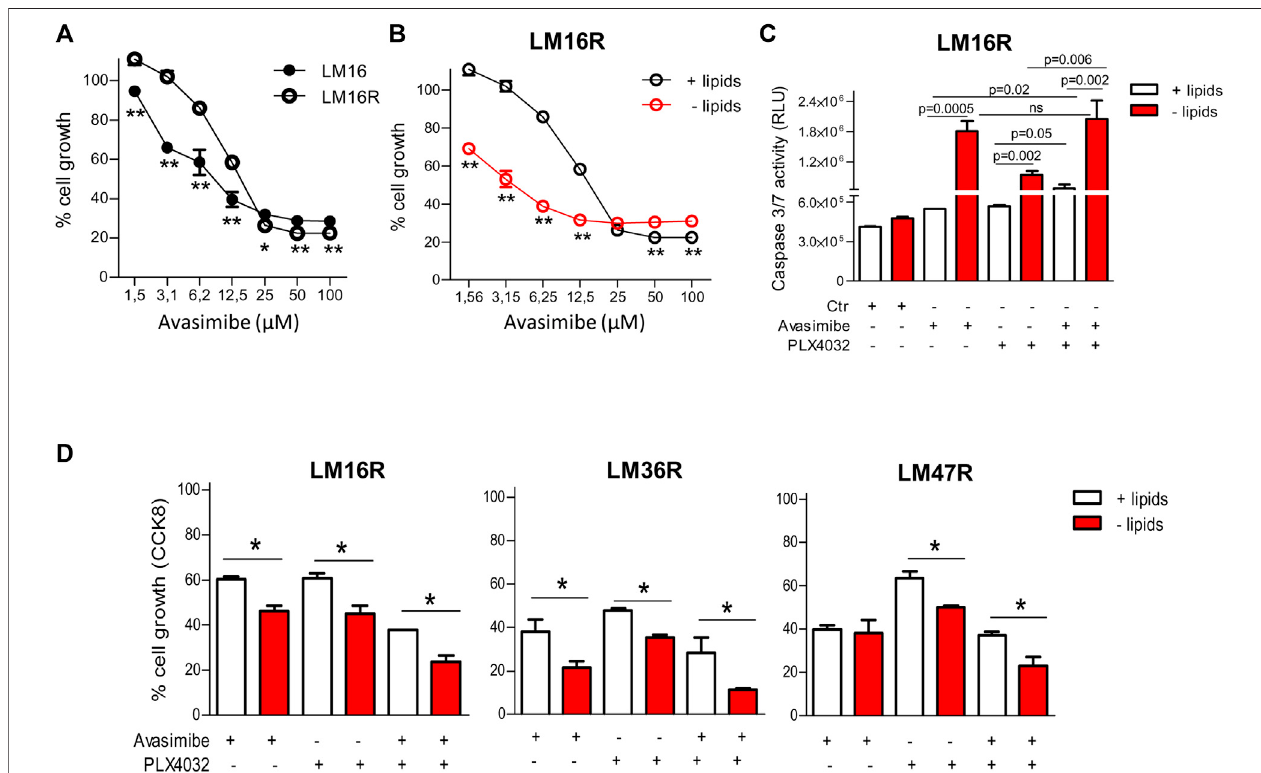
FIGURE 6 | Antiproliferative effects of avasimibe and of the combined treatment with PLX4032 in melanoma cell lines. (A) . Sensitivity of LM16/LM16R cells to avasimibeinstandardcultureconditions.IC 50 valuesofavasimibeforLM16RandLM16parentalcellswere17.1and11.1 µMinstandardculturemedium. (B) .Sensitivity ofLM16R cellstoavasimibe instandardculture conditionand uponlipid starvation. IC 50 valuesofavasimibe were17.1 µM instandardconditionand 4.2 µM inlipid-free medium. In (A) and (B) ** p < 0.01 by Two-way ANOVA followed by Bonferroni correction. (C) . Apoptosis induction after 48 h treatment with avasimibe (12.5 µM) and PLX4032 (3 µM) and with the combination in standard and lipid-free medium as detected by caspase 3/7 activity. p values by unpaired Student ’ s t test. ns: not signi fi cant. Ctr: untreated control. (D) . Sensitivity of LM16R, LM47R and LM36R cells to avasimibe (25 µM), PLX4032 (3 µM) alone or in combination as determined by CCK8assay.Dataareexpressedaspercentofcellgrowthcomparedtountreatedcontrol.* p < 0.05byOne-wayANOVAfollowedbyBonferronicorrection.Experiments were repeated four times.